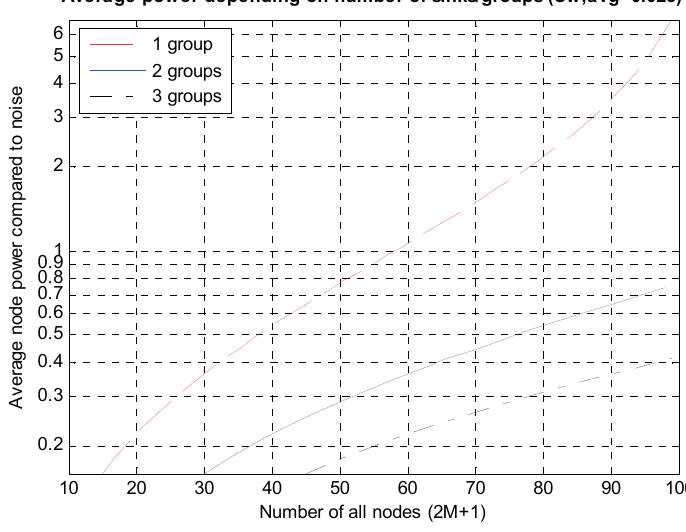
Figure 10. Decreases in the average power according to the network split.